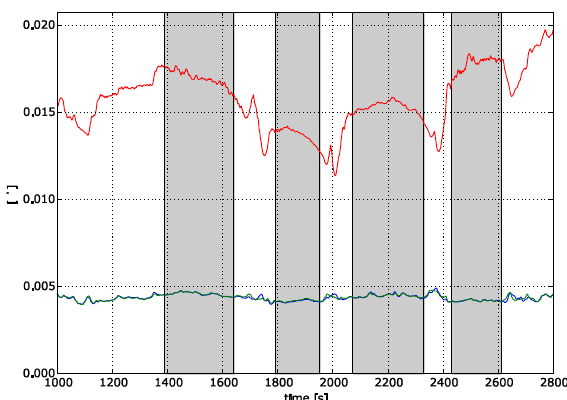
Figure 7. Estimated errors of roll (blue), pitch (green) and yaw (red) angles, provided as a result of trajectory post-processing. Flight #1. Strips are marked by gray segments. Data provided for period 1000 – 2800 s.